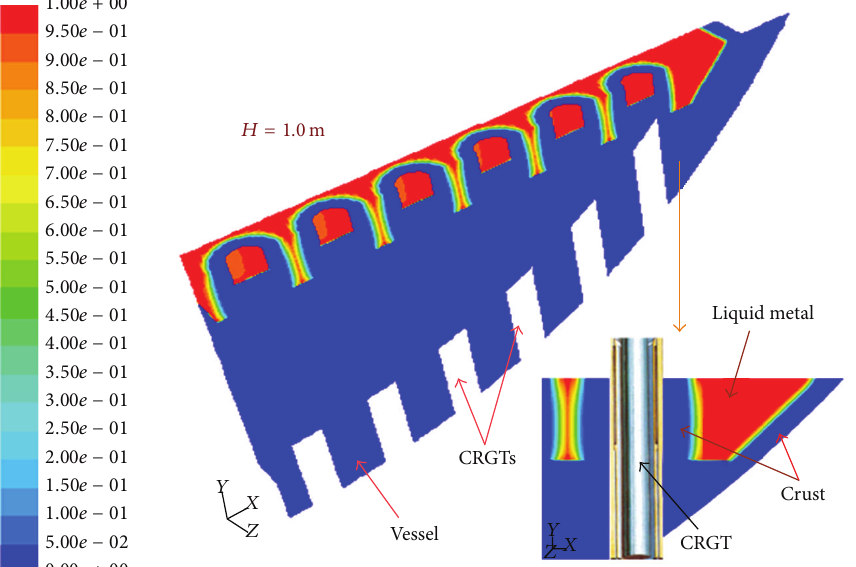
Figure 18: Liquid fraction contour of the stratified heterogeneous debris pool (transient).